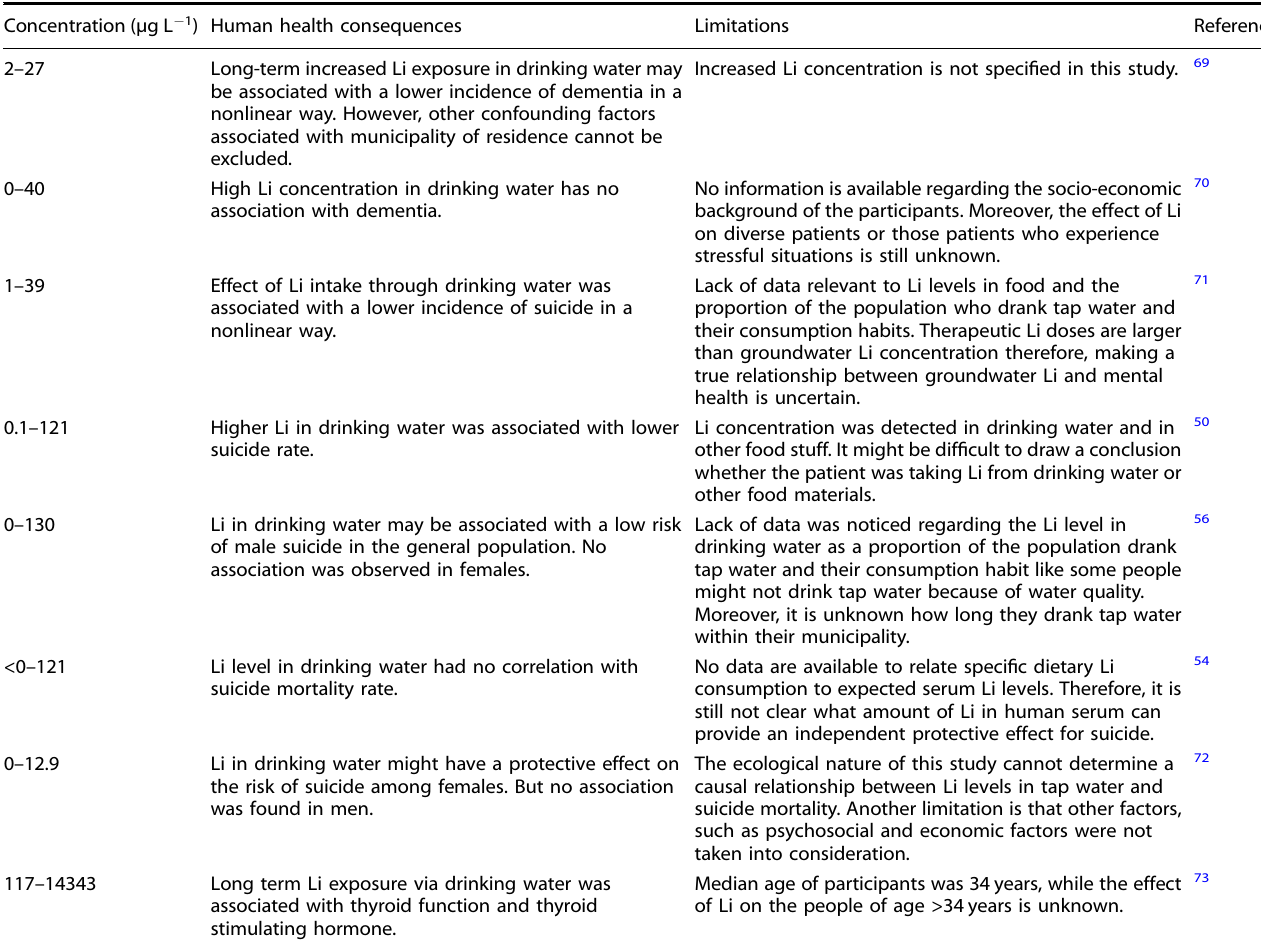
Table 1. Review of outcomes and limitations of studies on drinking water Li